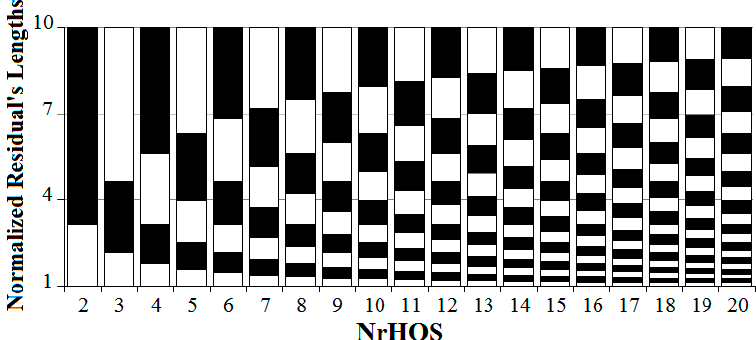
Figure 20. The range of the residual vectors lengths associated with each homogeneous set for different